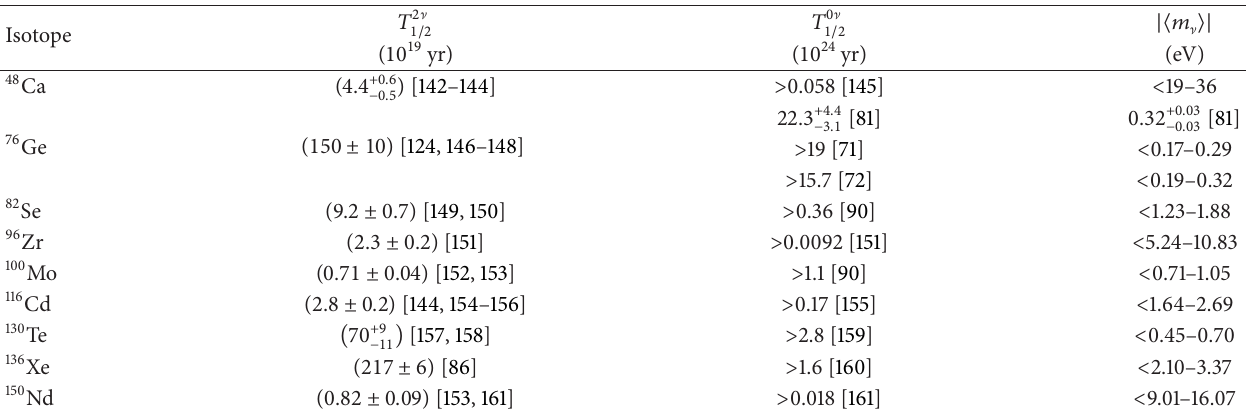
Table 4: Best reported results on 𝛽𝛽 processes. 𝛽𝛽(0 ] ) limits are at 90% C.L. Where nonexplicitely referenced, the effective neutrino mass ranges are obtained according to the QRPA calculations reported in Table